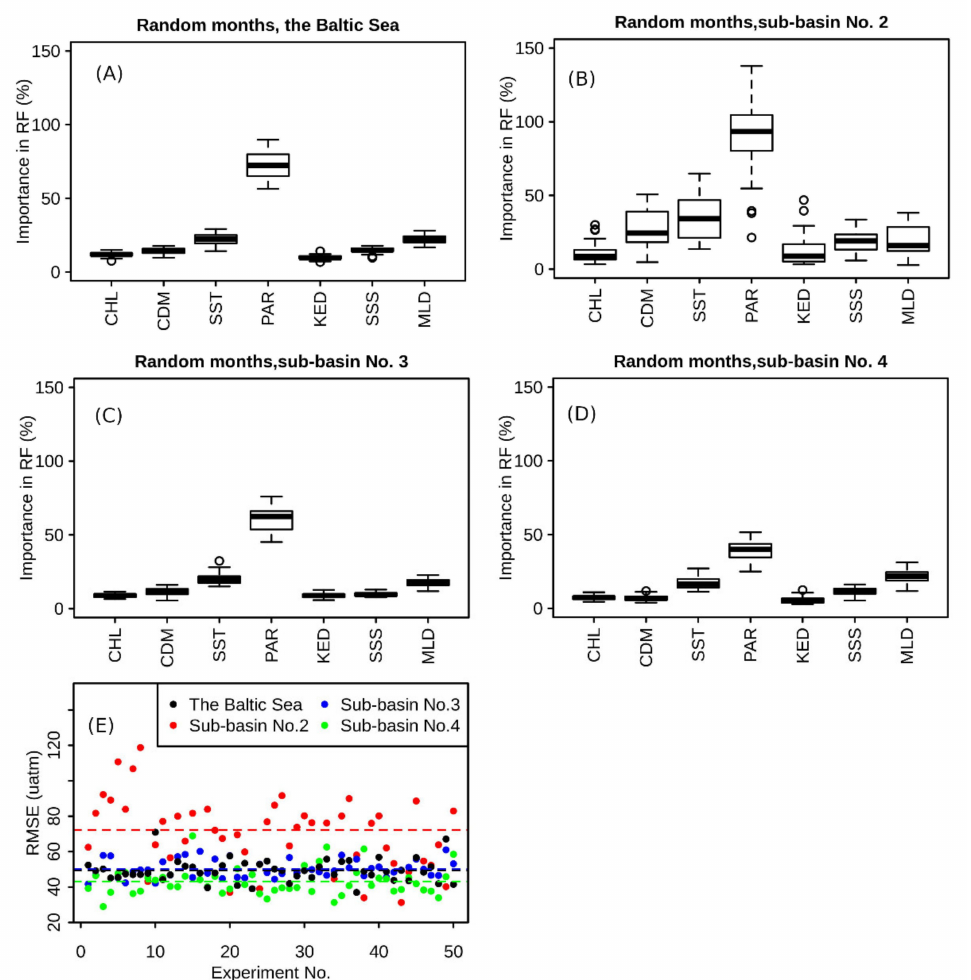
Figure 2. Variables’ importance for pCO 2 estimate in the Baltic Sea and its sub-basins. ( A ) Variables’ importance in the 50 models trained with in-situ data in the entire Baltic Sea from 2/3 months of random selection; ( B – D ) Variables’ importance in the 50 models trained with in-situ data from each sub-basin from 2/3 months of random selection. ( E ) The RMSEs of the 50 models trained with in-situ data from the four regions, respectively. CDM in the sub-figures donates the aCDOM derived from Medium Resolution Imaging Spectrometer (MERIS) images, KED stands for